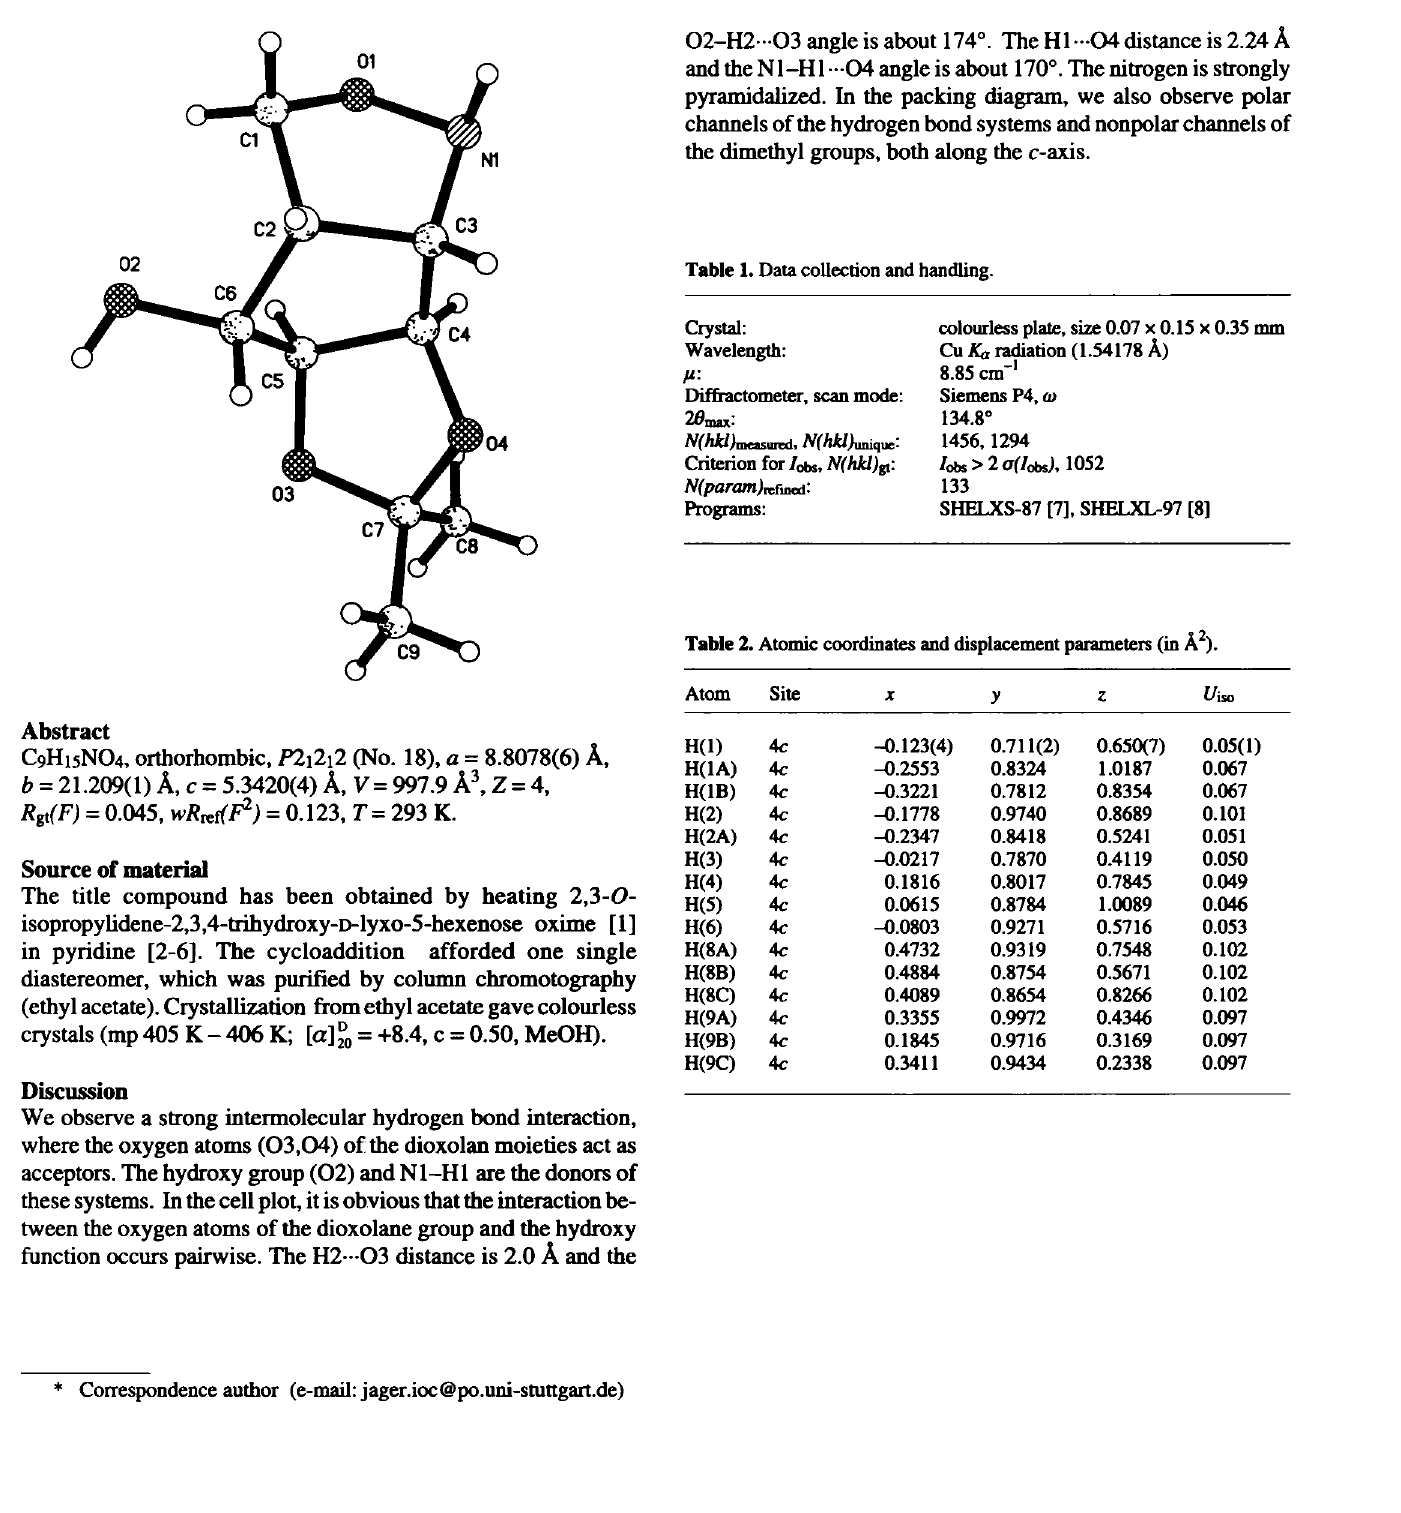
Table 1. Data collection and handling.